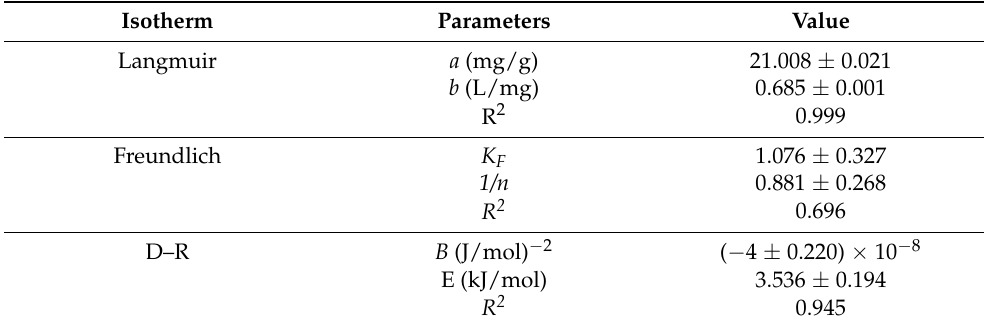
Table 3. The isotherm parameters.